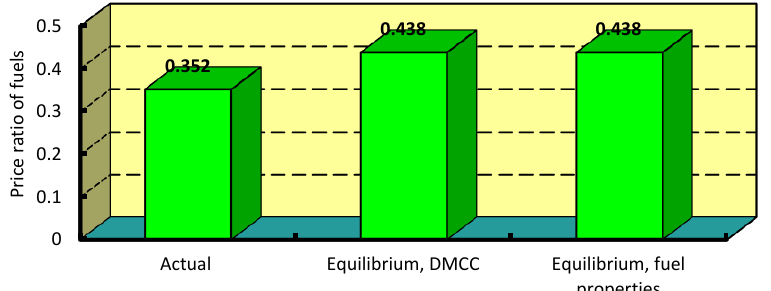
Figure 11. Methanol to diesel fuel price ratio: actual, maximum acceptable.